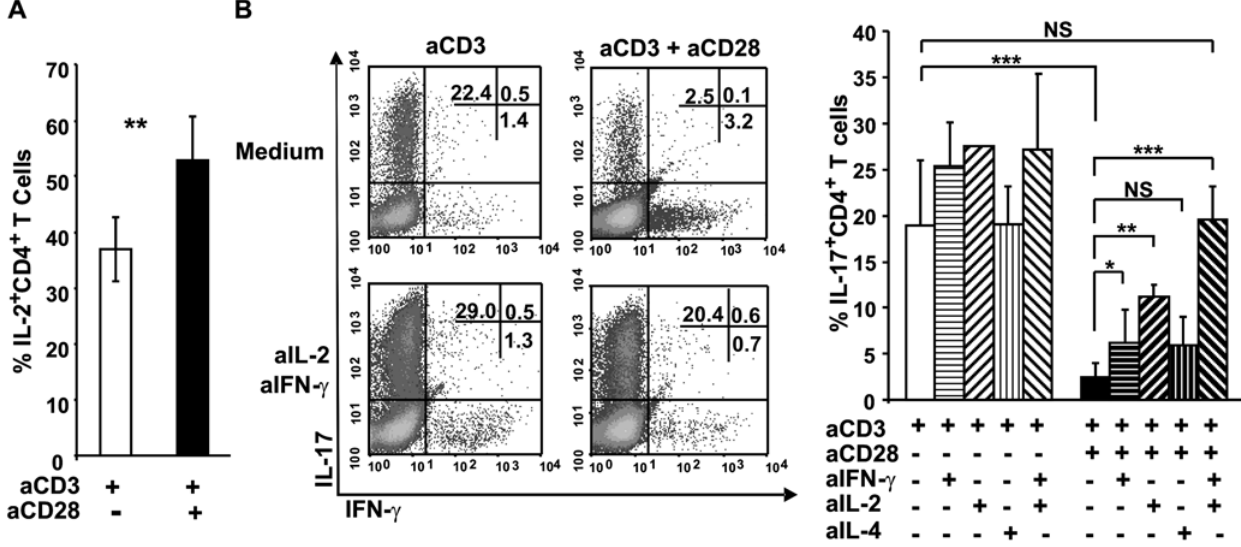
Figure 4. The CD28-driven inhibition of Th17 differentiation is mediated by IL-2 and IFN- c production. Purified CD4 + T cells were stimulated with plate-bound anti-CD3 in the presence or the absence of soluble anti-CD28 mAb under Th17 polarizing conditions. (A) The percentages of IL-2 + CD4 + T cells from 7 independent experiments (mean 6 SEM). (B) CD4 + T cells were cultured in the presence or absence of anti- mouse IL-4, IFN- c or IL-2 alone or in combination. The data shown are representative of 1 experiment out of 3 (dot plots, left panel). The cumulative data from 2–6 independent experiments are shown in the right panel. P values were calculated using the two-tailed, paired Student’s t test, *, P , 0.05; **, P , 0.01; ***, P ,